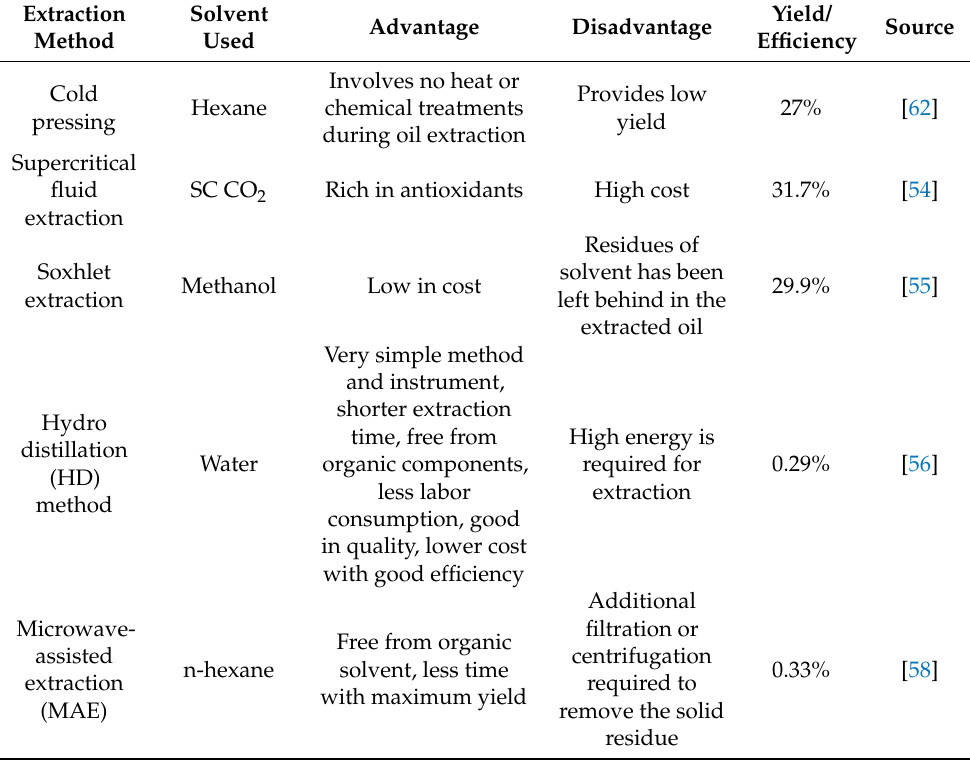
Table 1. Different extraction methods of Nigella sativa seeds